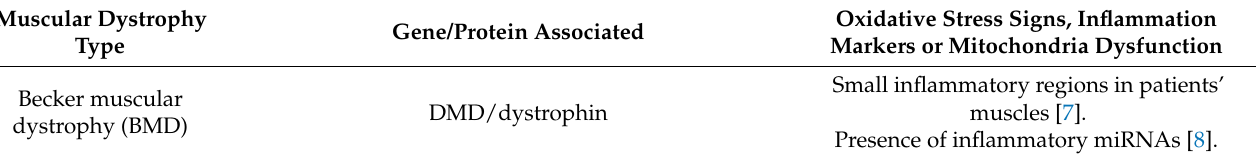
Table 1. Muscular dystrophy types, genes involved and reported oxidative stress signs, inflammation markers and mitochondria traits in patients’ biopsies and animal